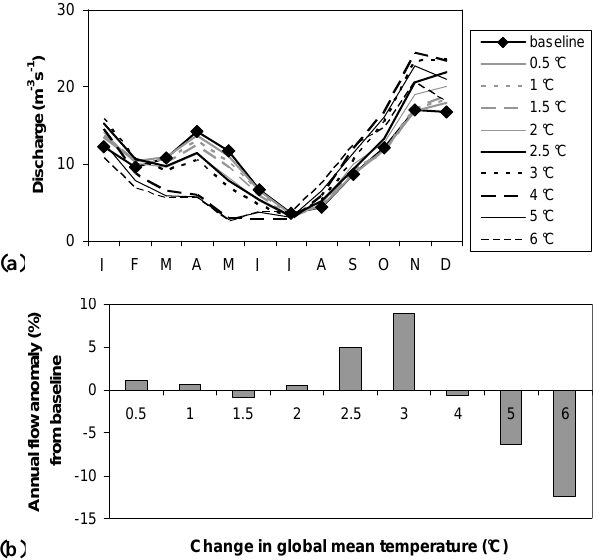
Figure 4 Fig. 4. Climate change signal in (a) monthly and (b) annual dis- charge for the River Mitano under HadCM3 prescribed warming scenarios.